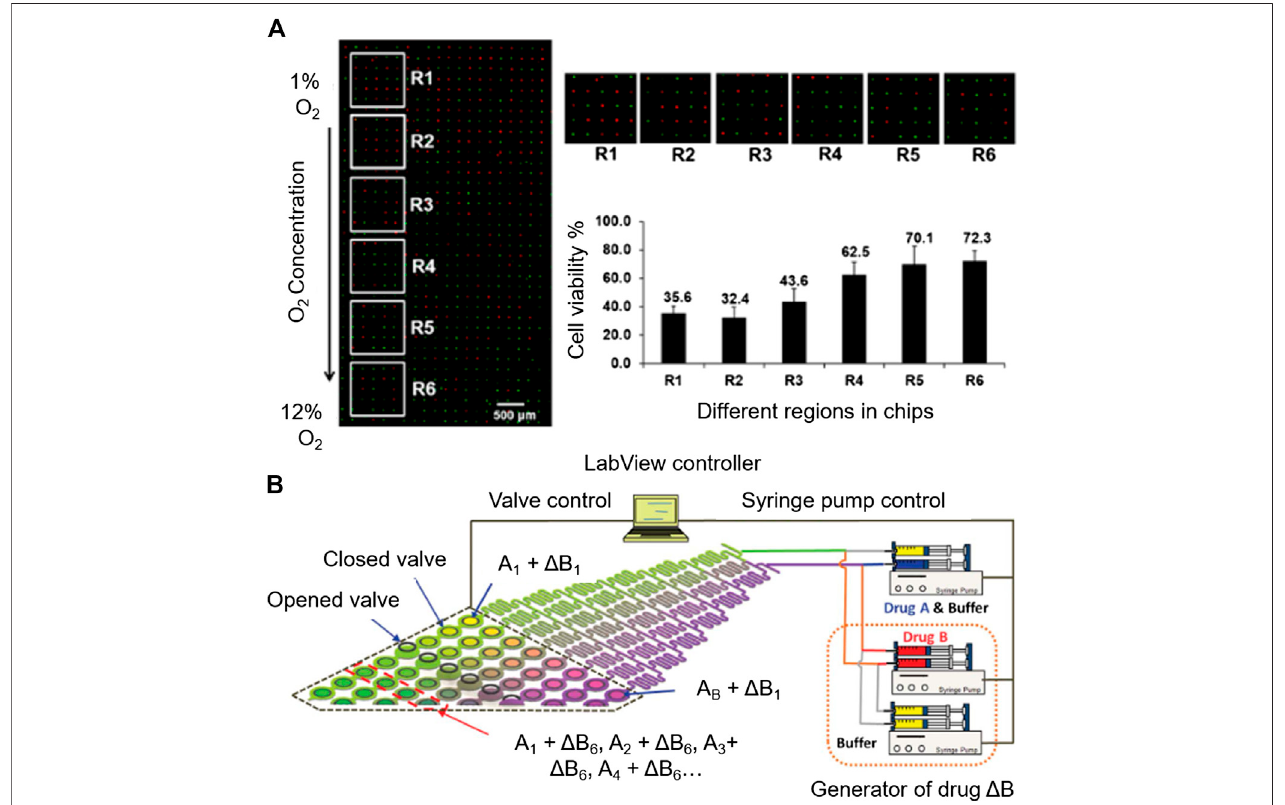
FIGURE6 | Automationpotentialofmicrosystemsfor cytotoxicityassessment. (A) Automated imaging by fl uorescence microscopy. Reproduced withpermission from(Lietal.,2018).Copyright © 2018AmericanChemicalSociety. (B) Automatablemicro fl uidicsystemforcombinatorialcytotoxicityscreening.Reproducedfrom(Kim et al., 2012) with permission from The Royal Society of